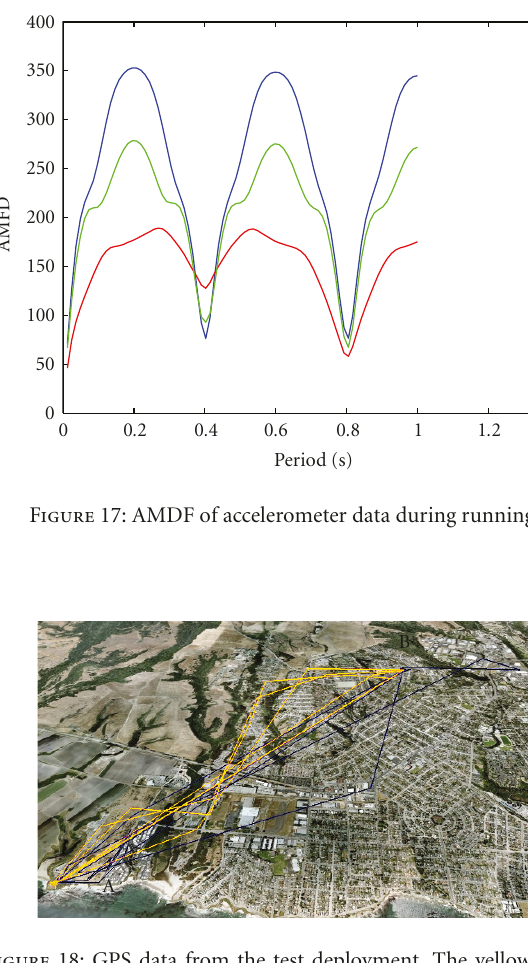
Figure 18: GPS data from the test deployment. The yellow track was logged by the GPS on a CSN carried by a researcher. The black track is the GPS data from the CSN carried by a domestic dog. An SRN was located at Long Marine Lab, Santa Cruz, CA, USA (A). The dog lived at B and his owner worked at A. Data was successfully transferred to the SRN via hops 1 and 2.